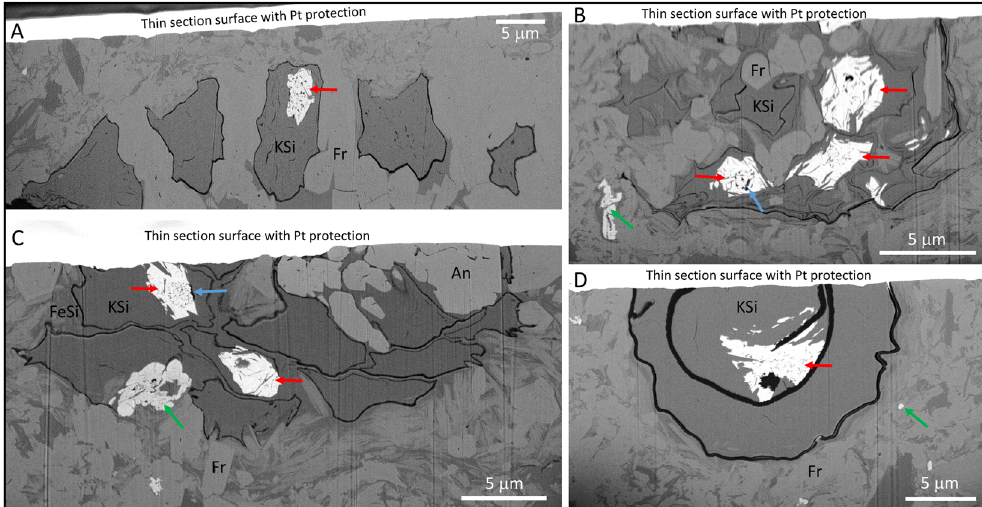
Figure 3. SEM-BSE images of FIB-milled cross sections through selected microfossils illustrated in Fig. 2, highlighting the location of REE phosphate. ( A ) Cross section through the cluster of cells illustrated in Fig. 2A. ( B ) Cross section through the organism illustrated in Fig. 2E. ( C ) Cross section through the cluster of cells illustrated in Fig. 2F. ( D ) Cross section through the organism illustrated in Fig. 2G. Red arrows point to monazite within cells; green arrows to xenotime; blue arrows to best examples of spheroidal organic ICIs; Fr = francolite; KSi = potassium silicates; FeSi = iron/magnesium silicates; An =